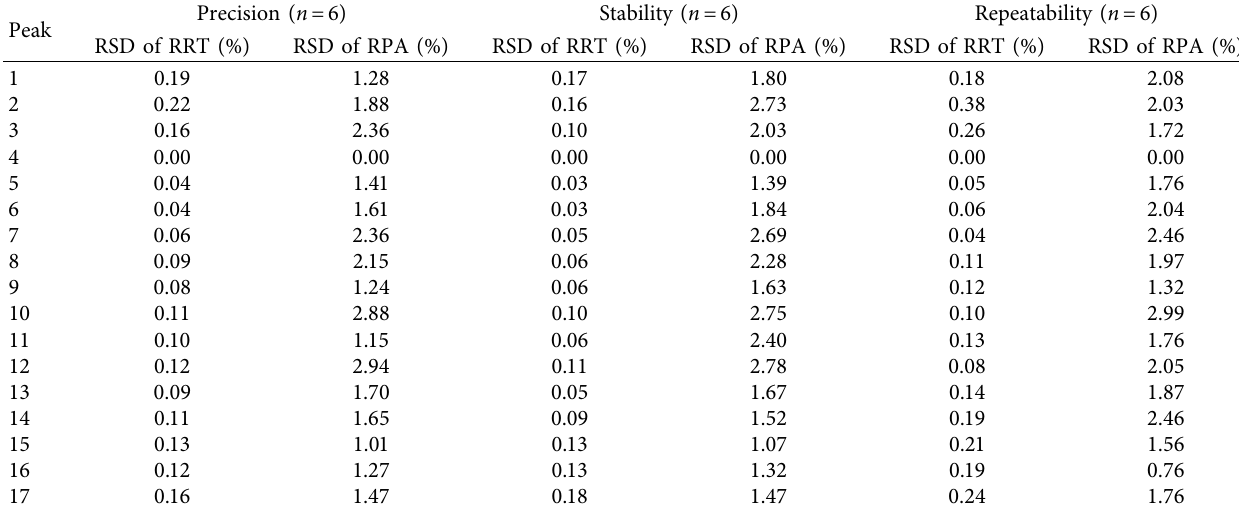
Table 1: RSD results of precision, stability, and repeatability.